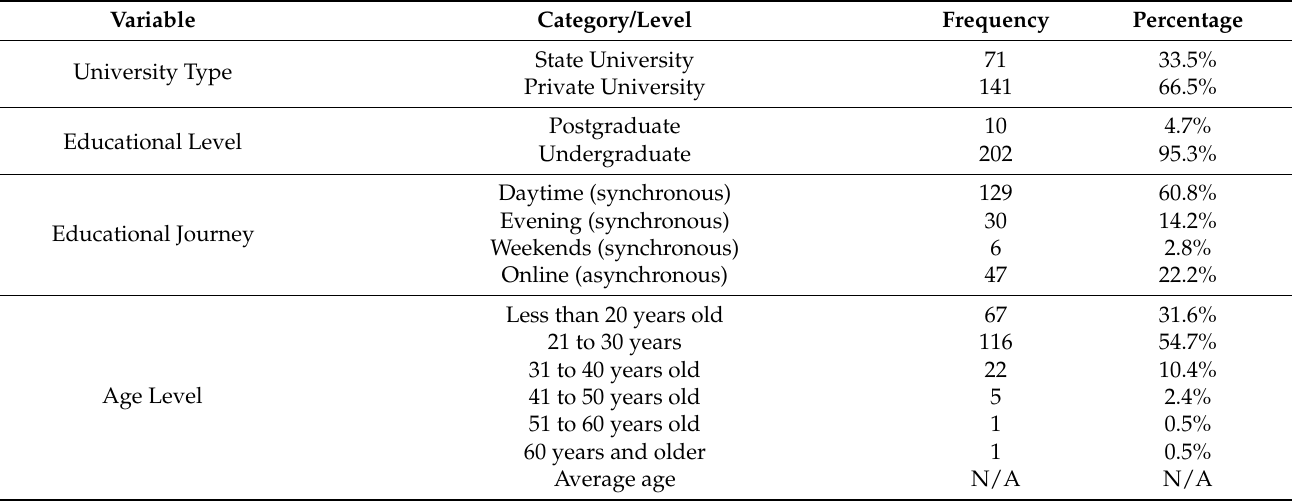
Table 2. Participant sample